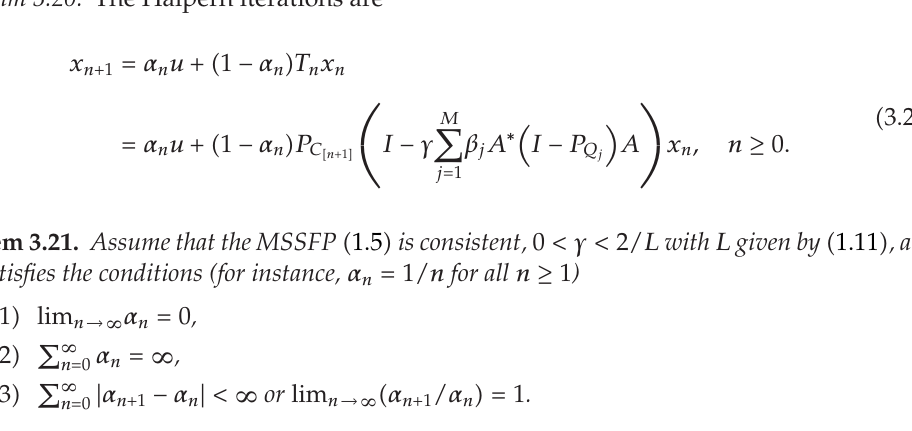
Algorithm 3.20. The Halpern iterations are